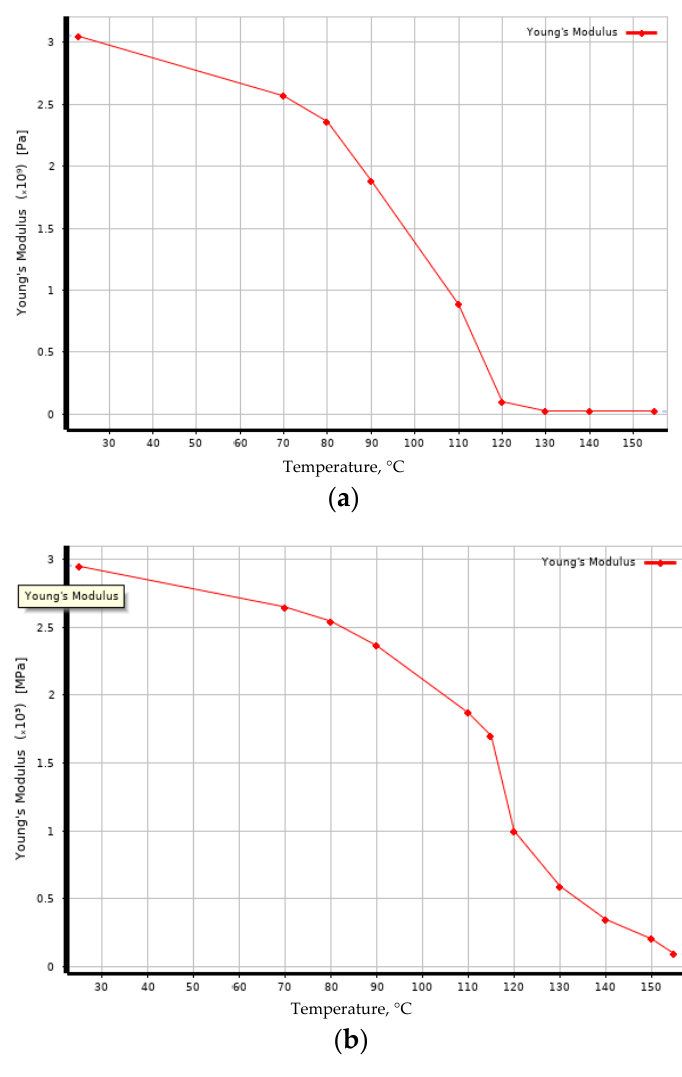
Figure 8. Dependence of elastic modulus of epoxy binder on temperature: ( a ) before exposure; ( b ) after exposure.